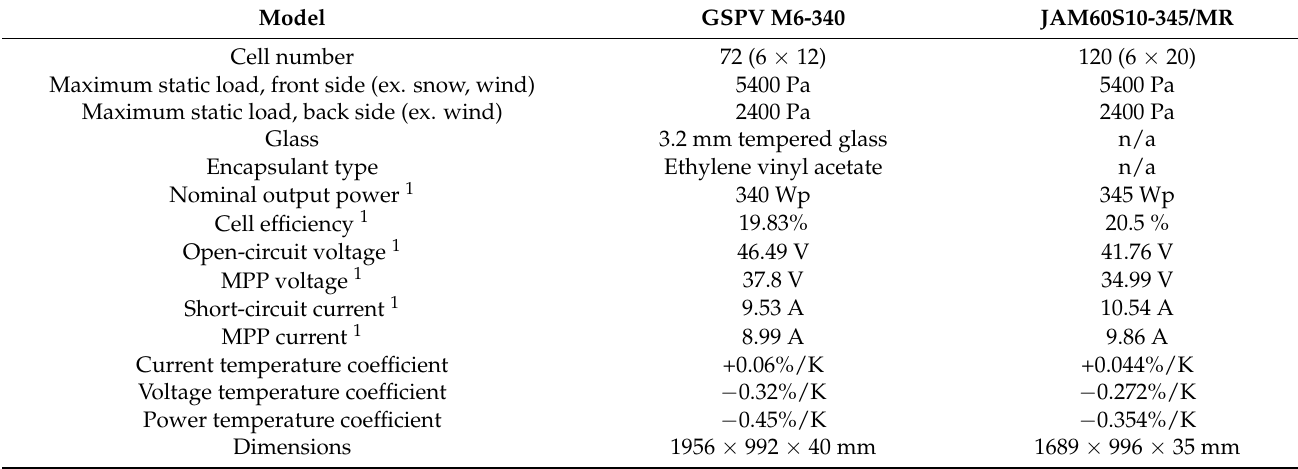
Table 1. Technical characteristics of the original 340 Wp monocrystalline silicon PV modules.